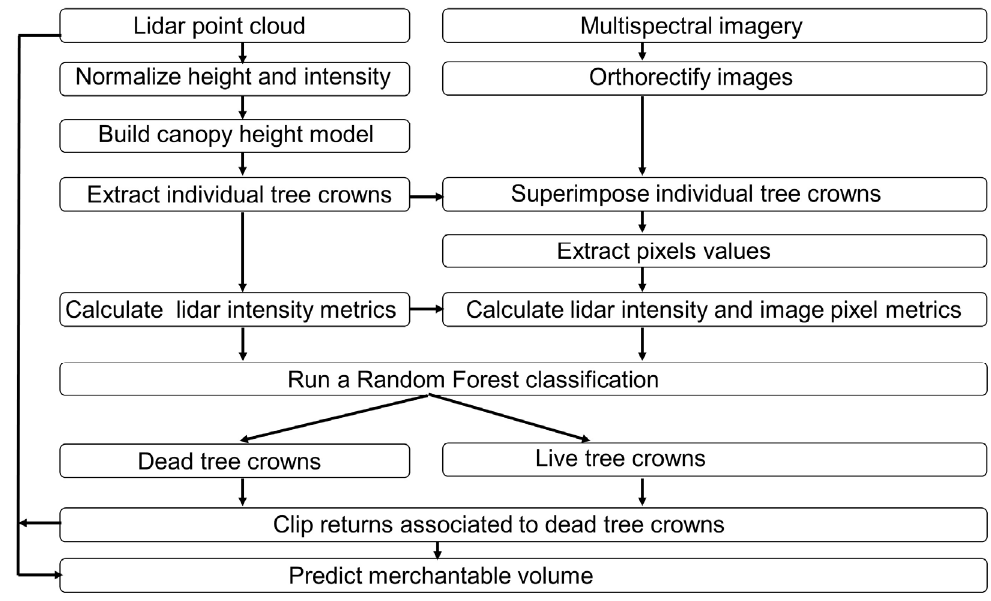
Figure 2. Workflow diagram describing the steps from the lidar and multispectral imagery data processing to the classification of individual tree crowns and the prediction of the merchantable volume.